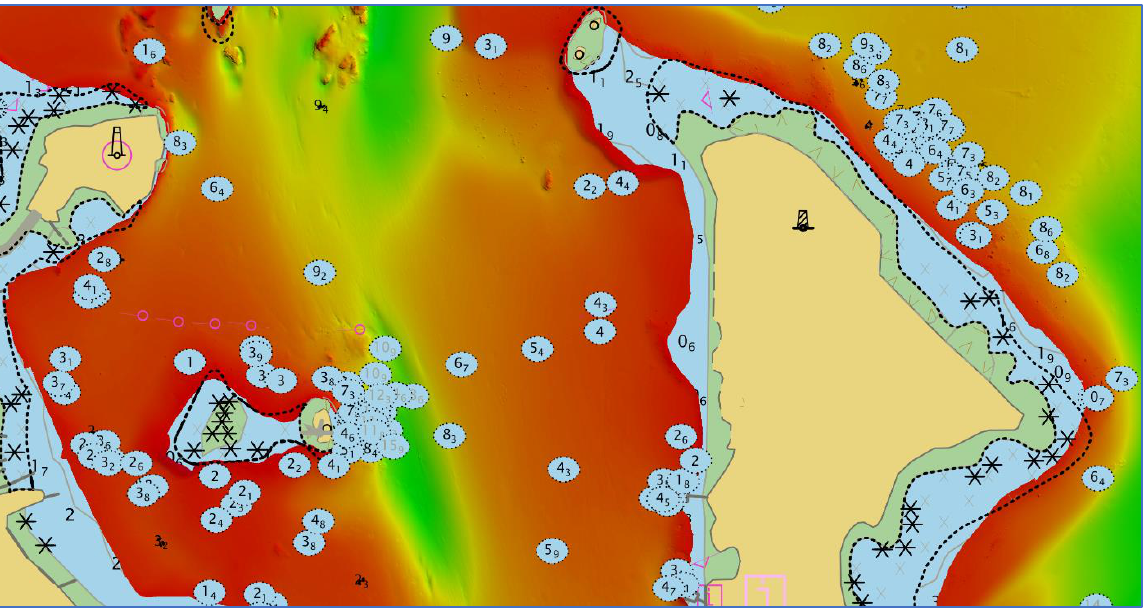
Figure 2. In nautical chart updates, the sheer number of features (represented by light blue circles, with the feature least depth sounding displayed inside) in nearshore areas is a task poorly befitting a manual review and is greatly aided by automation. Shown here is an Electronic Navigational Chart (ENC) US5NYCFJ, depicting part of the Western Long Island Sound, New York, NY, USA, with prospective chart features overlain atop gridded multibeam bathymetry (both from NOAA hydrographic survey H13384), which is colored by depth. All soundings are in meters; when shown, the sub-index represents decimeters.